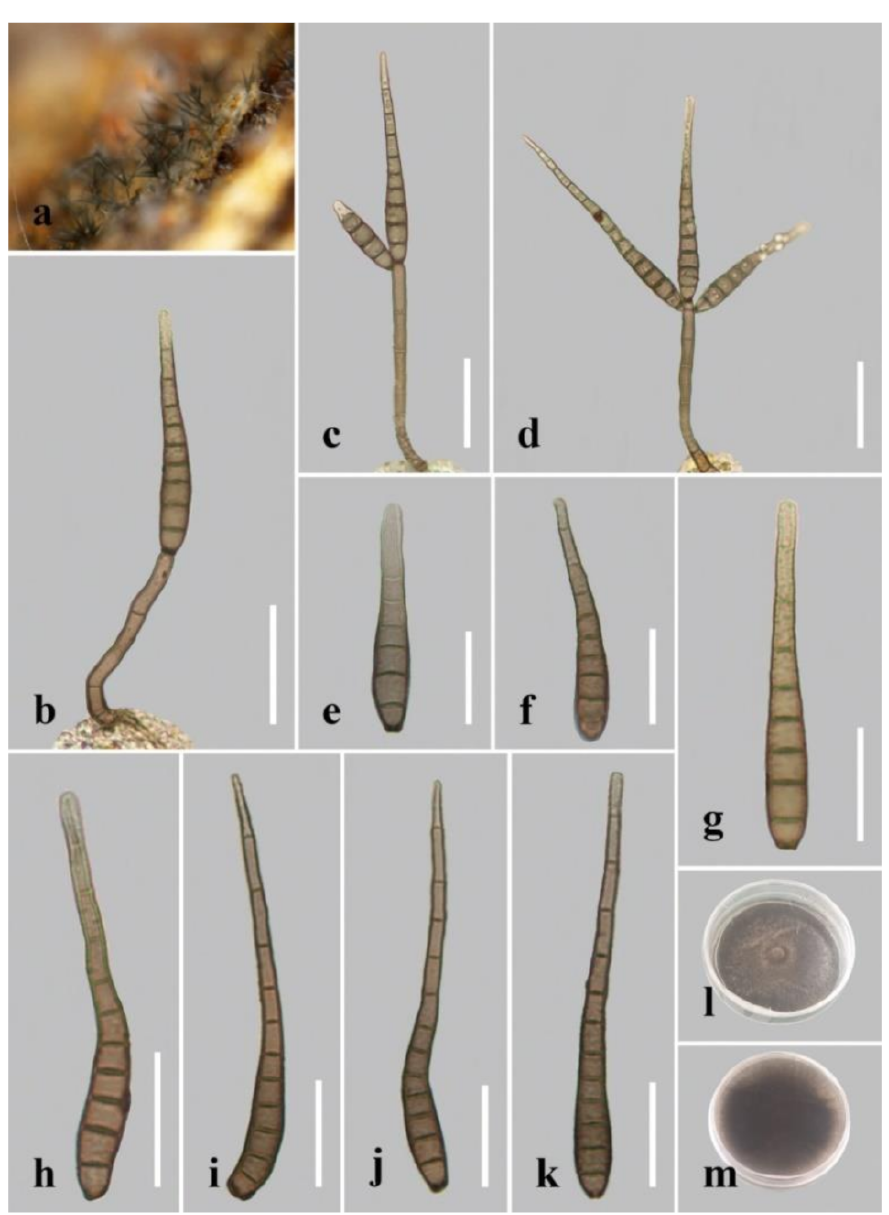
Figure 5. Distoseptispora bambusae . ( a ) Colonies on natural substrate. ( b – d ) Conidiophores with conidia. ( e – k ) Conidia. ( l ) Colony on PDA (from front). ( m ) Colony on PDA (from reverse). Scale bars: ( b – d ) 30 µ m; ( e – k ) 20 µ